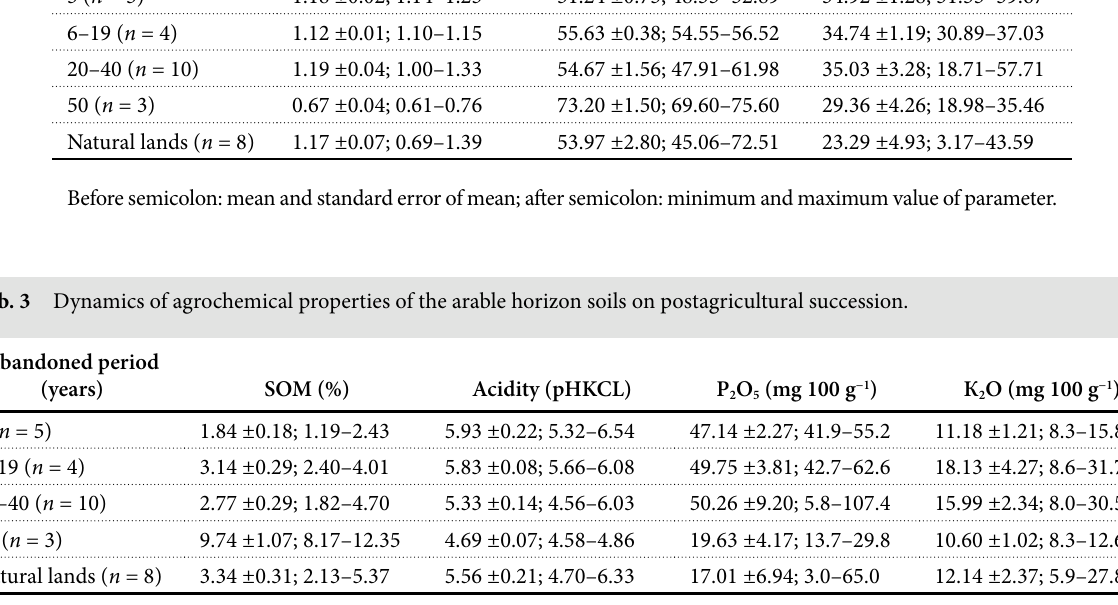
Before semicolon: mean and standard error of mean; after semicolon: minimum and maximum value of